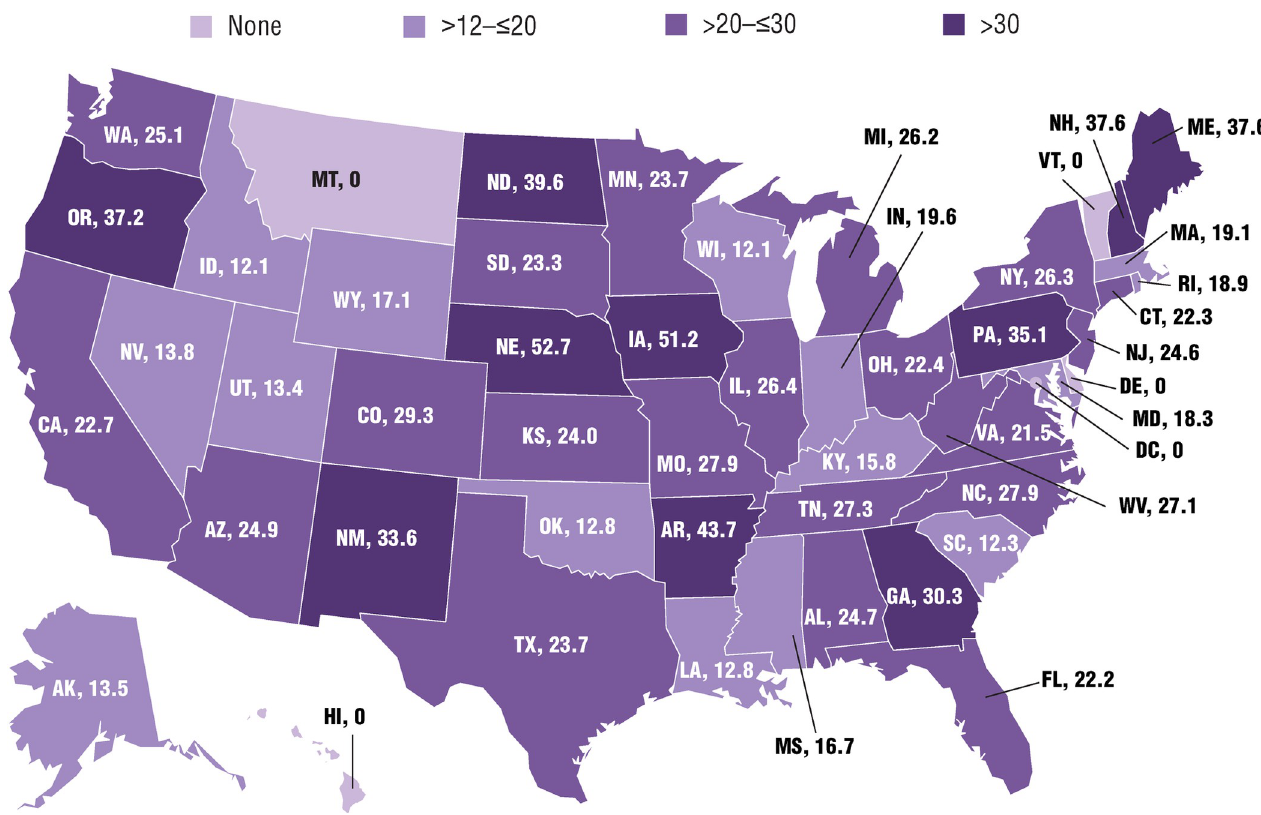
Fig 3. Survey respondents per 10 million residents in each state. 775 respondents provided home state information.